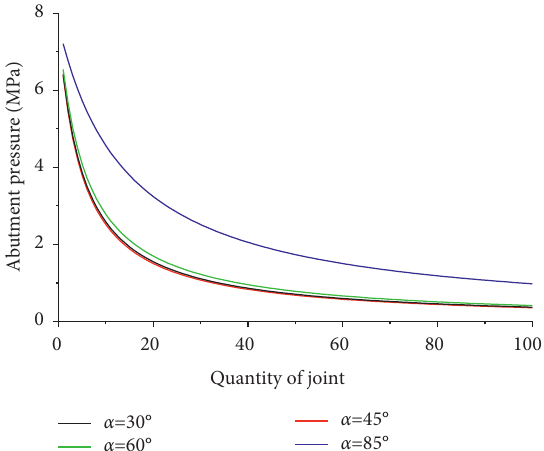
Figure 13: Change in abutment pressure in LEZ with number of joints in a fully mechanised working face with large mining